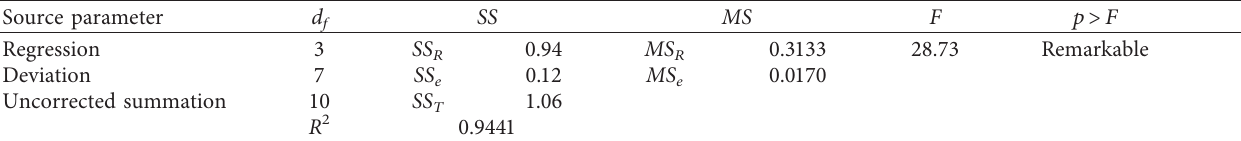
2 regression equation for peak displacement of mixed cement and gravel